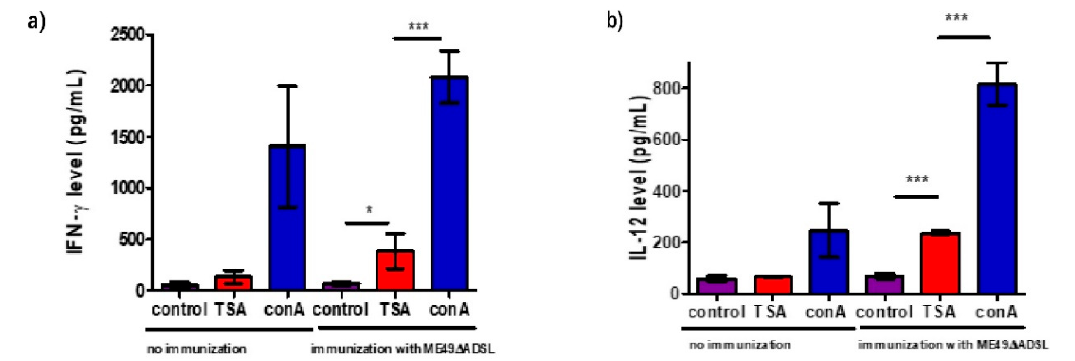
Figure 6. Cytokine production by splenocytes of ME49 ∆ ADSL -vaccinated mice after Toxoplasma antigen stimulation. ICR mice were vaccinated with 100 tachyzoites of ME49 ∆ ADSL , and splenocytes were harvested 150 days post-vaccination. The in vitro cultured splenocytes were then treated with fetal bovine serum (control), total soluble Toxoplasma antigen (TSA) or concanavalin A (conA, positive control) for 72 h. Subsequently, the levels of IFN- γ ( a ) and IL-12 ( b ) in the culture supernatants were measured by ELISA. Splenocytes isolated from non-immunized naïve mice were included as controls. Three mice from each group were analyzed, and each treatment condition was repeated three times. * p < 0.05, *** p < 0.001, Student’s t -test.